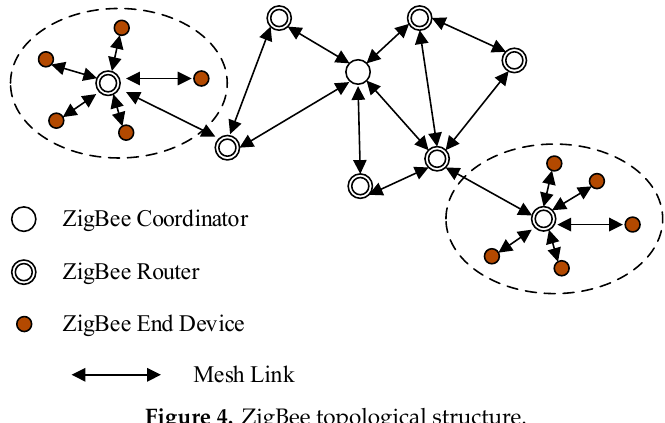
Figure 4. ZigBee topological structure.